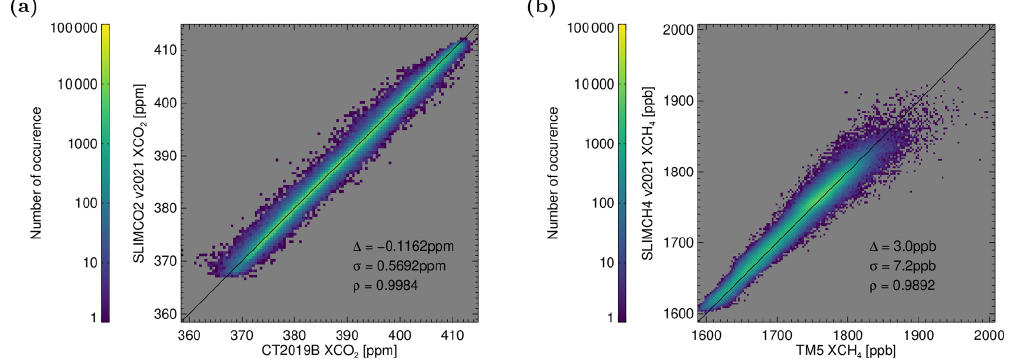
Figure A3. Scatter plot of the data shown in Fig. A2. (a) SLIMCO2 data vs. CT2019B; (b) SLIMCH4 vs. TM5. Symbol σ corresponds to the standard deviation of the difference, δ corresponds to the average bias and ρ is the Pearson correlation